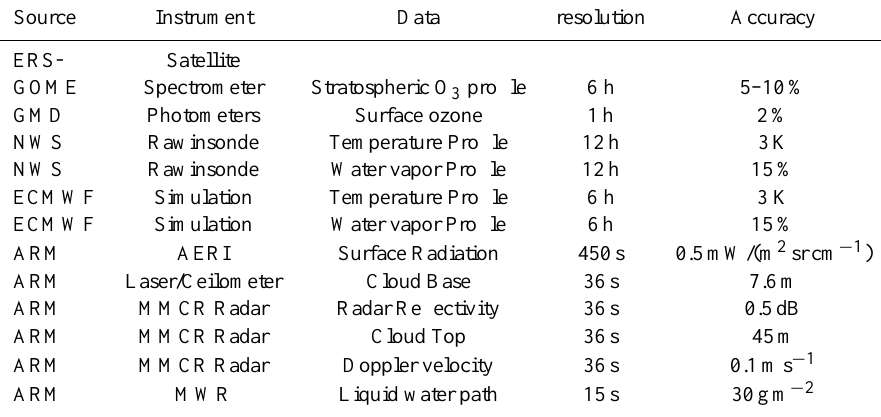
Table 1. Site, instrument, resolution, and 95% confidence accuracy of measurements used in this study.